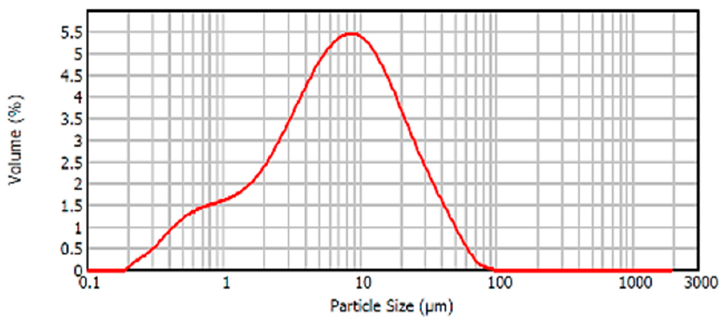
Figure 8. Particle size distribution BFS.